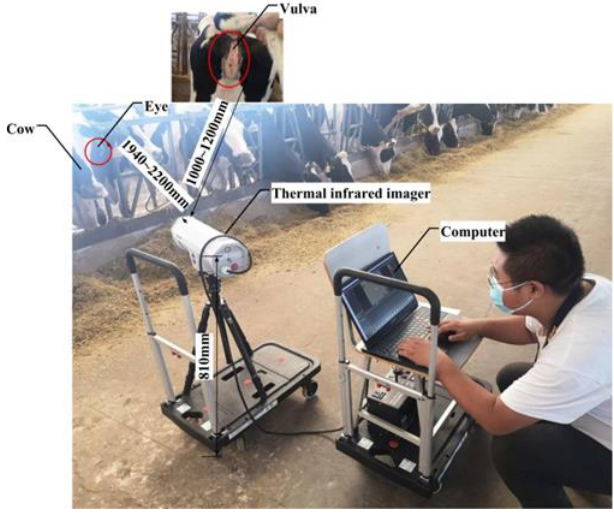
Figure 1. Schematic diagram of thermal infrared image acquisition of dairy cows.